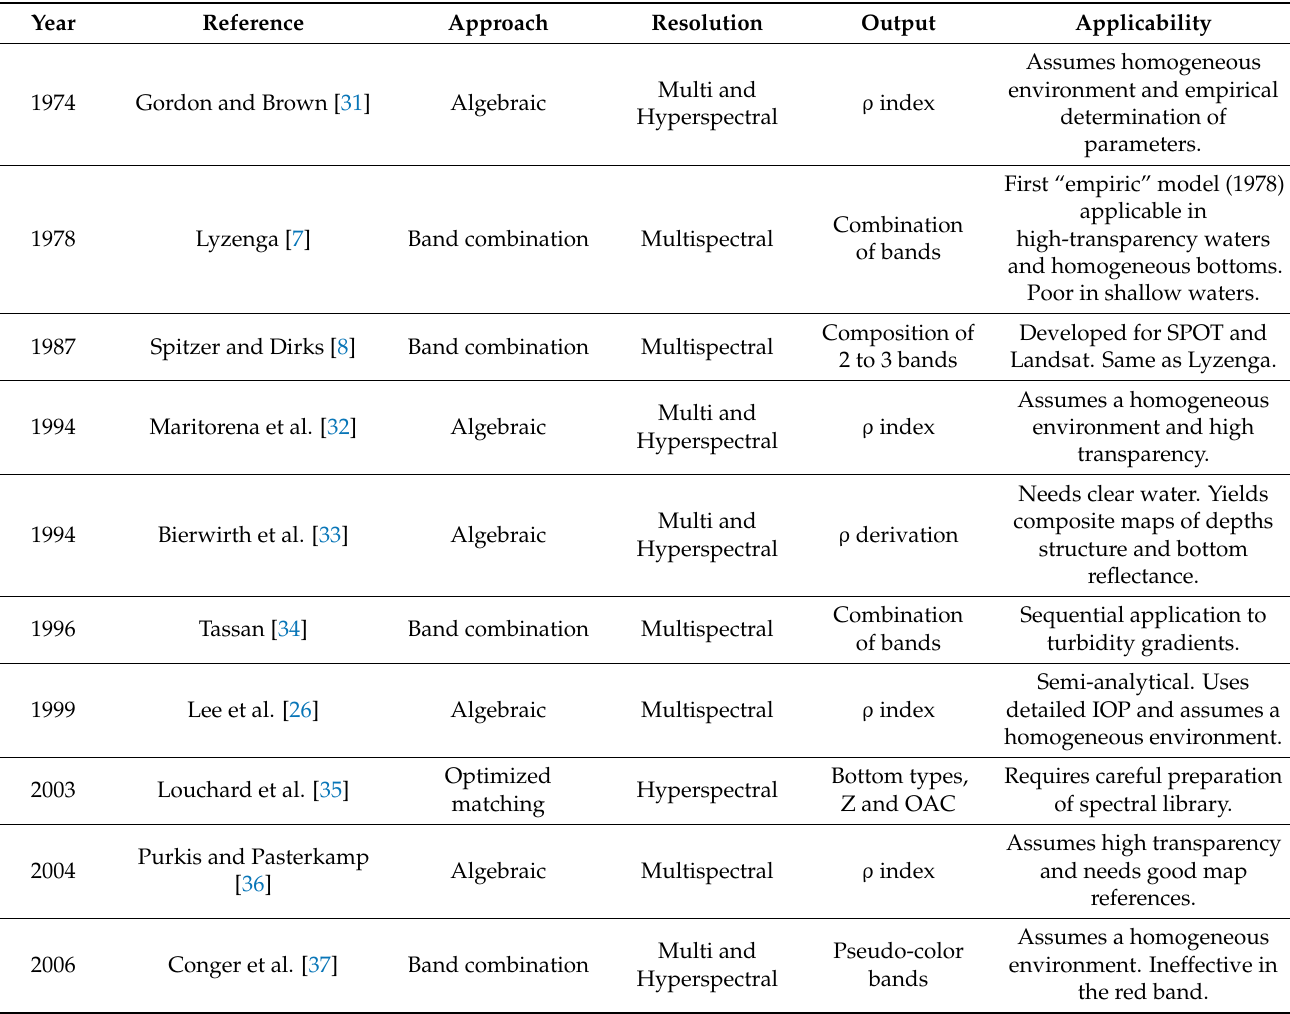
Table 2. Summary of models reviewed considering the methodological approach, data spectral resolution, data required, model results and other observations